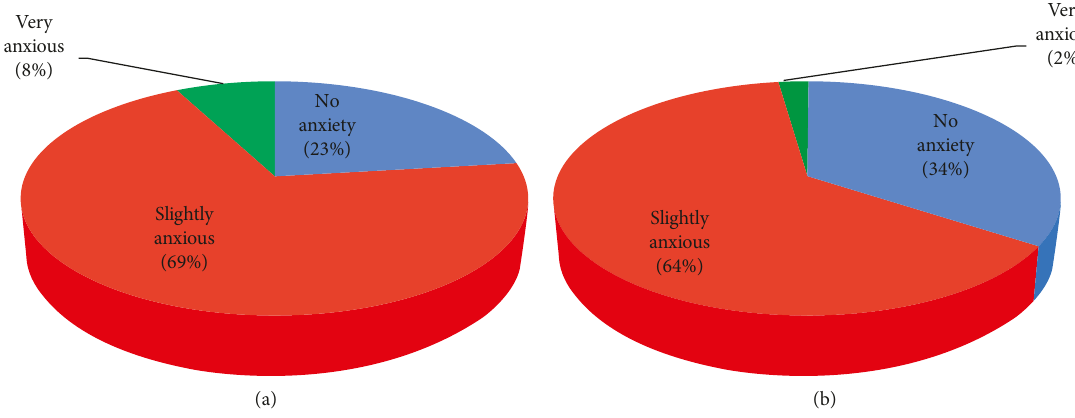
Figure 3: Level of total anxiety in relation to gender. (a) Percentage of total anxiety within males. (b) Percentage of total anxiety within females.